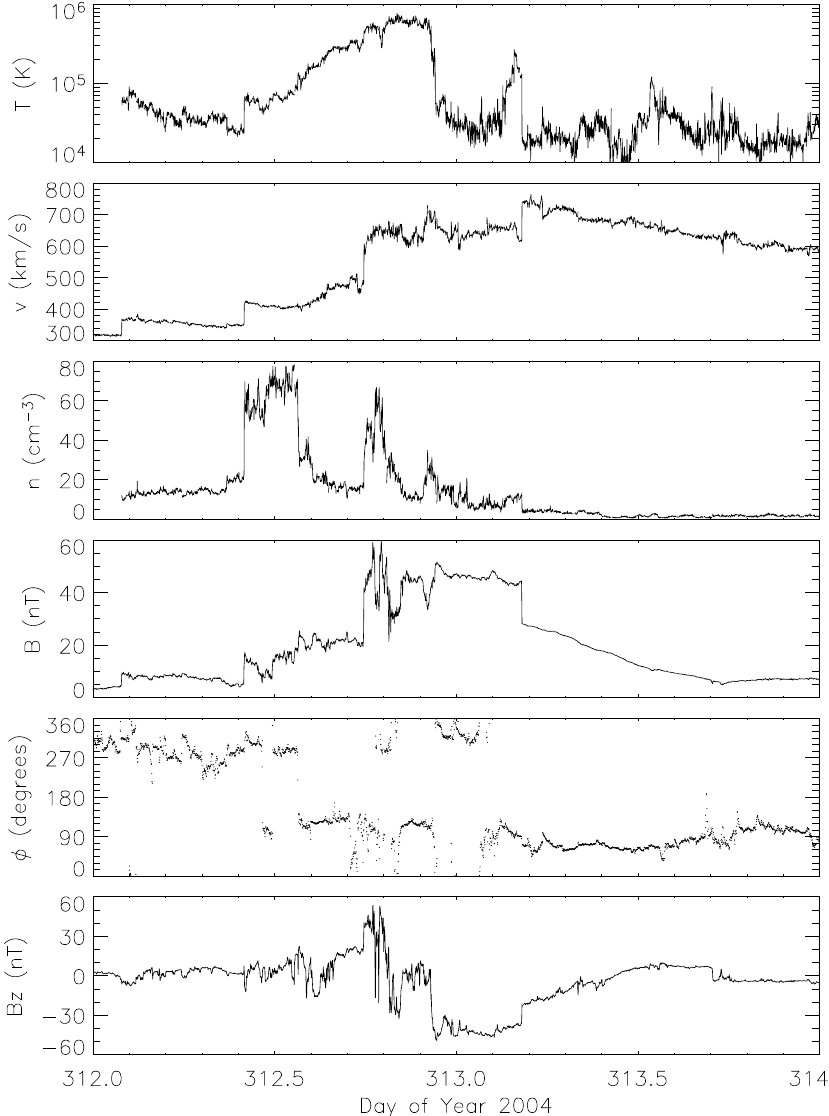
Fig. 10. ACE MAG and SWEPAM data showing the compound ICME structure on 7–8 November (DOY 312–313). From top to bottom: proton temperature, solar wind speed, proton number density, magnetic field, longitudinal angle 8 , magnetic field Bz component (in GSE coordinate